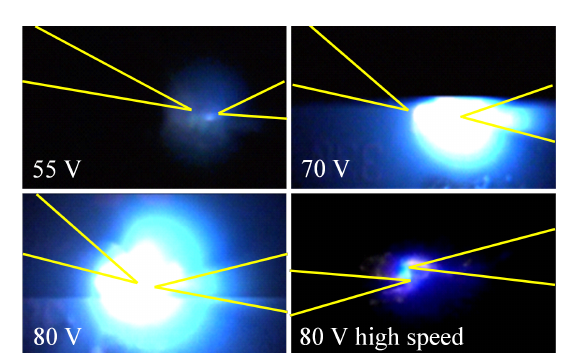
Figure 4: Frames extracted from high-resolution videos showing light emission from the ZnO nanorods contacted by tungsten probes during AC excitation of 10–10000 Hz with the indicated peak-to-peak voltage level. The approximate probe separation was 10–15 μ m. Similar visible emissions occurred with pulsed excitation. The probe positions are as indicated in